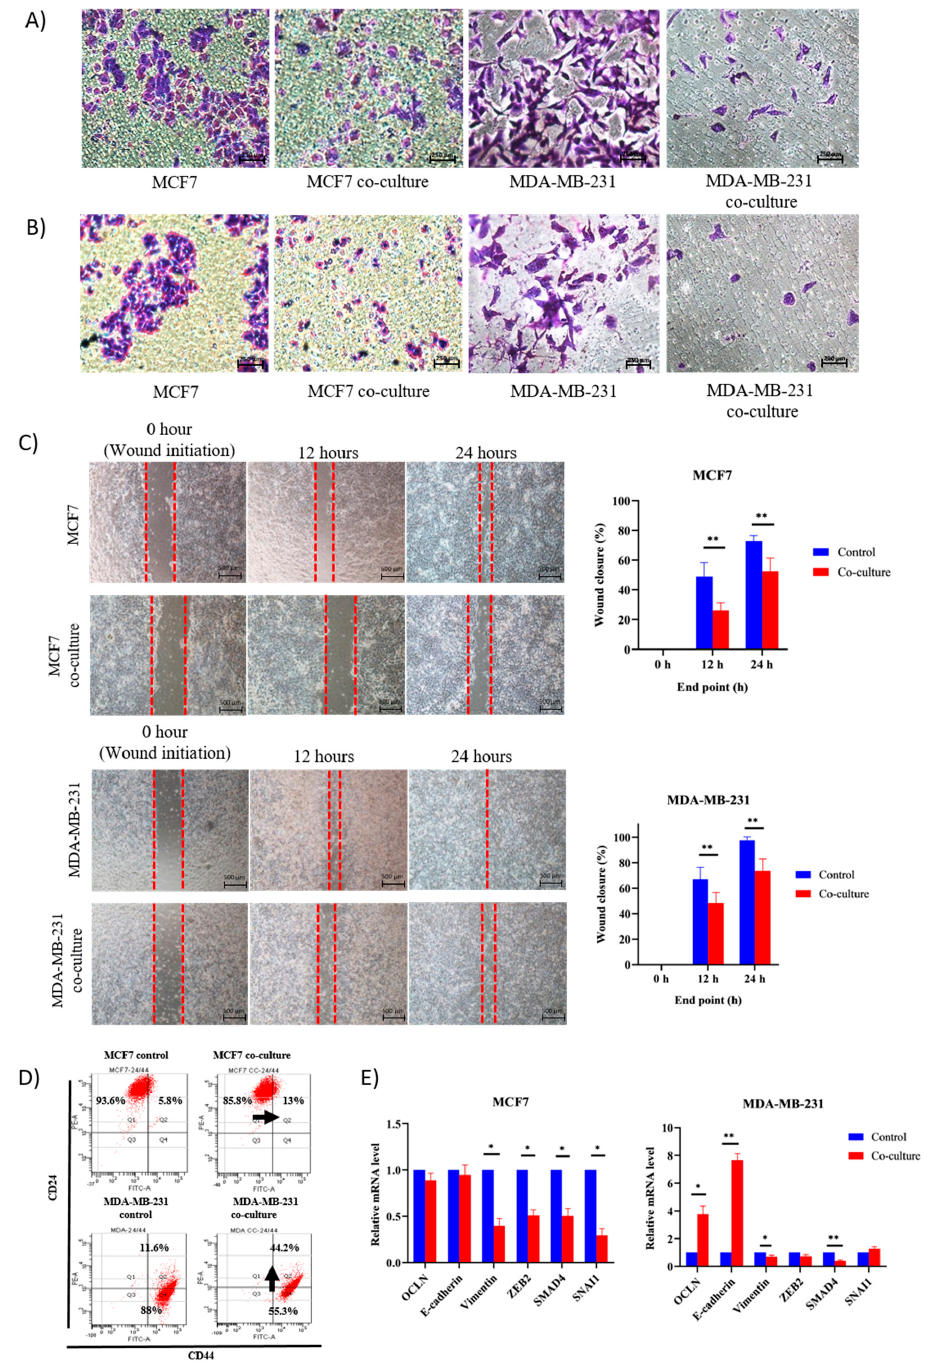
Figure 2. Metastasis capacity of cancer cells co-cultured with MSC. ( A ) Inhibition of migration assay (20 × magnification). ( B ) Inhibition of invasion assay (20 × magnification). ( C ) Decreased wound healing ability (10 × magnification). The dotted line represents the corresponding edges approximations for the wound gap created using scratch technique. Ability of cells to migrate and close the gap represents their migration ability. ( D ) Alteration in epithelial (CD24) and mesenchymal (CD44) surface markers expressions. ( E ) Alteration in epithelial and mesenchymal genes expression level. The results were analyzed using a t-test with mean values ± SD. * p < 0.05 and ** p < 0.01 compared with the non-co-culture